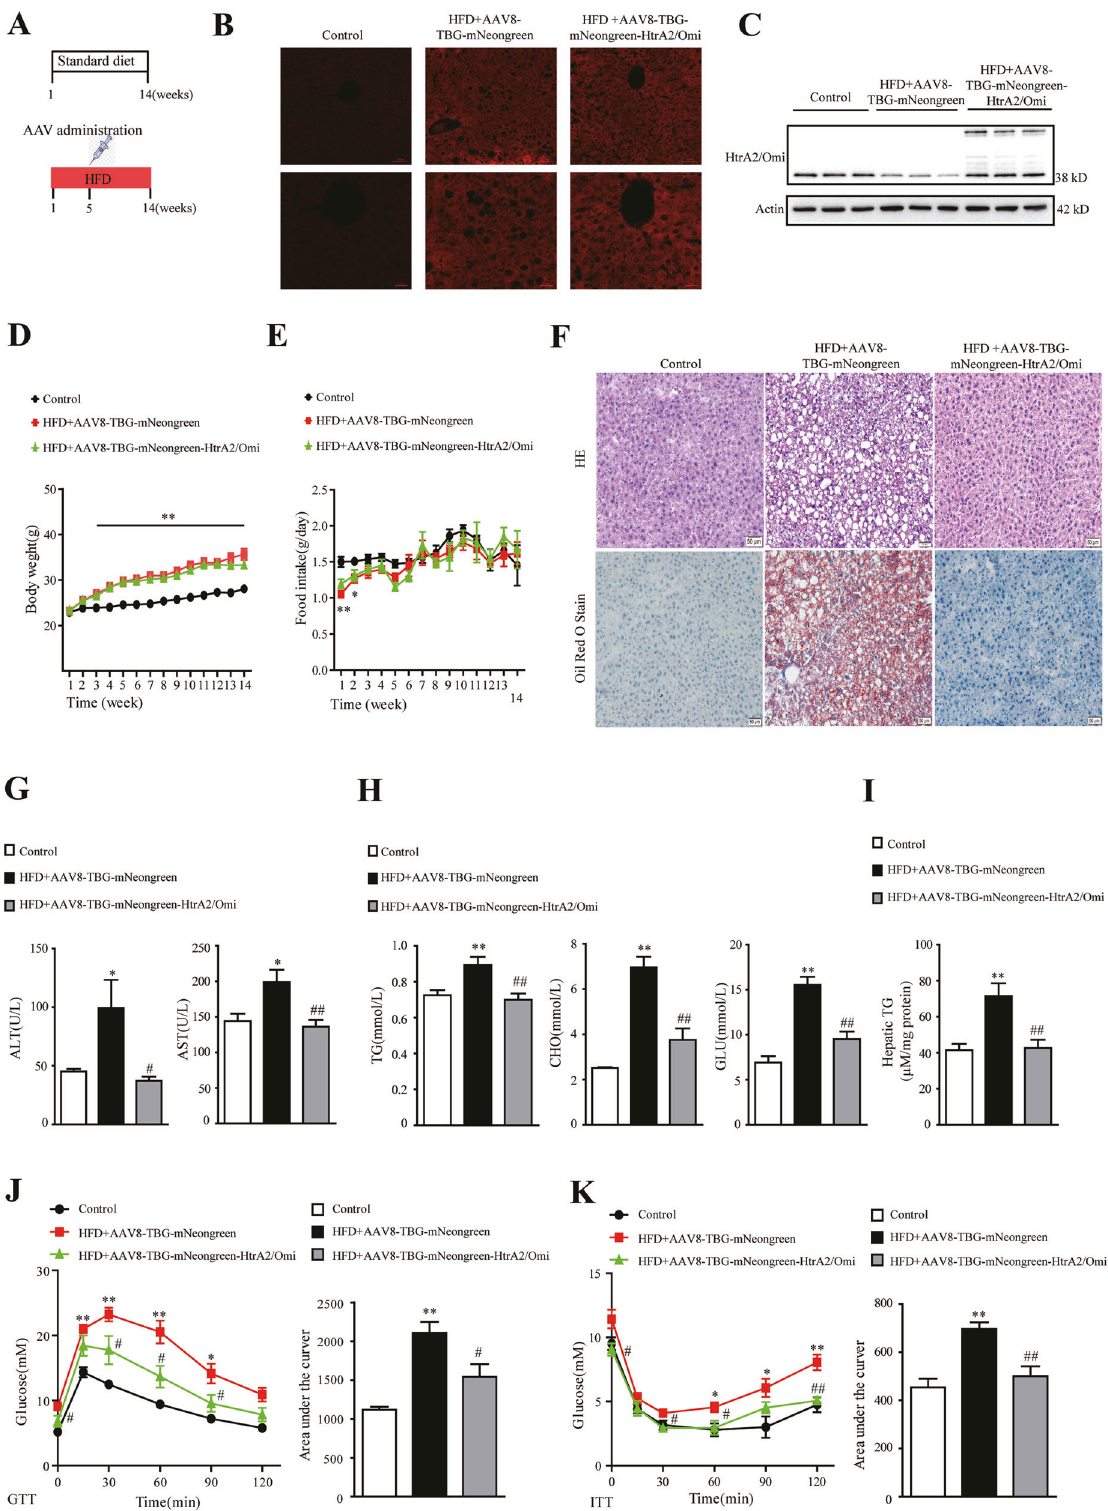
(Supplementary Fig. S1F, S1G). As the most critical metabolic organ, the liver plays an essential role in regulating blood- glucose homeostasis. In this study, HFD mice showed a signi fi cant increase in glucose tolerance and insulin resistance (Supplementary Fig. S1H,